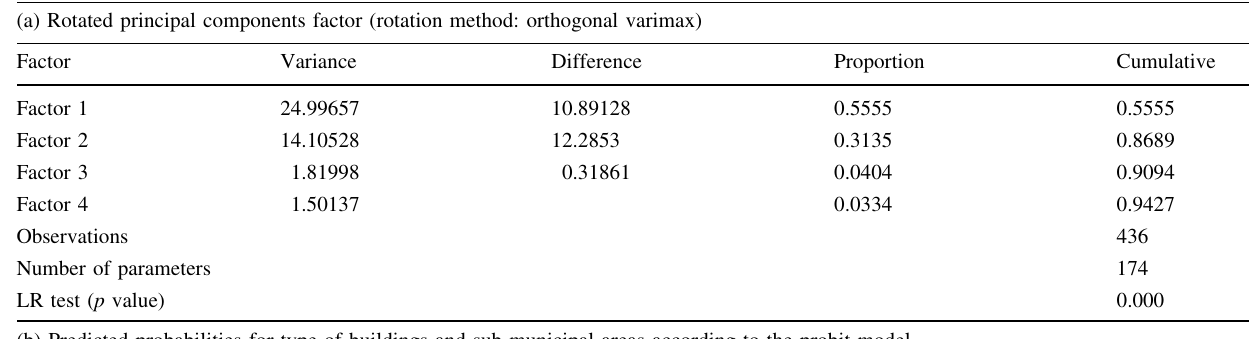
(b) Predicted probabilities for type of buildings and sub-municipal areas according to the probit model